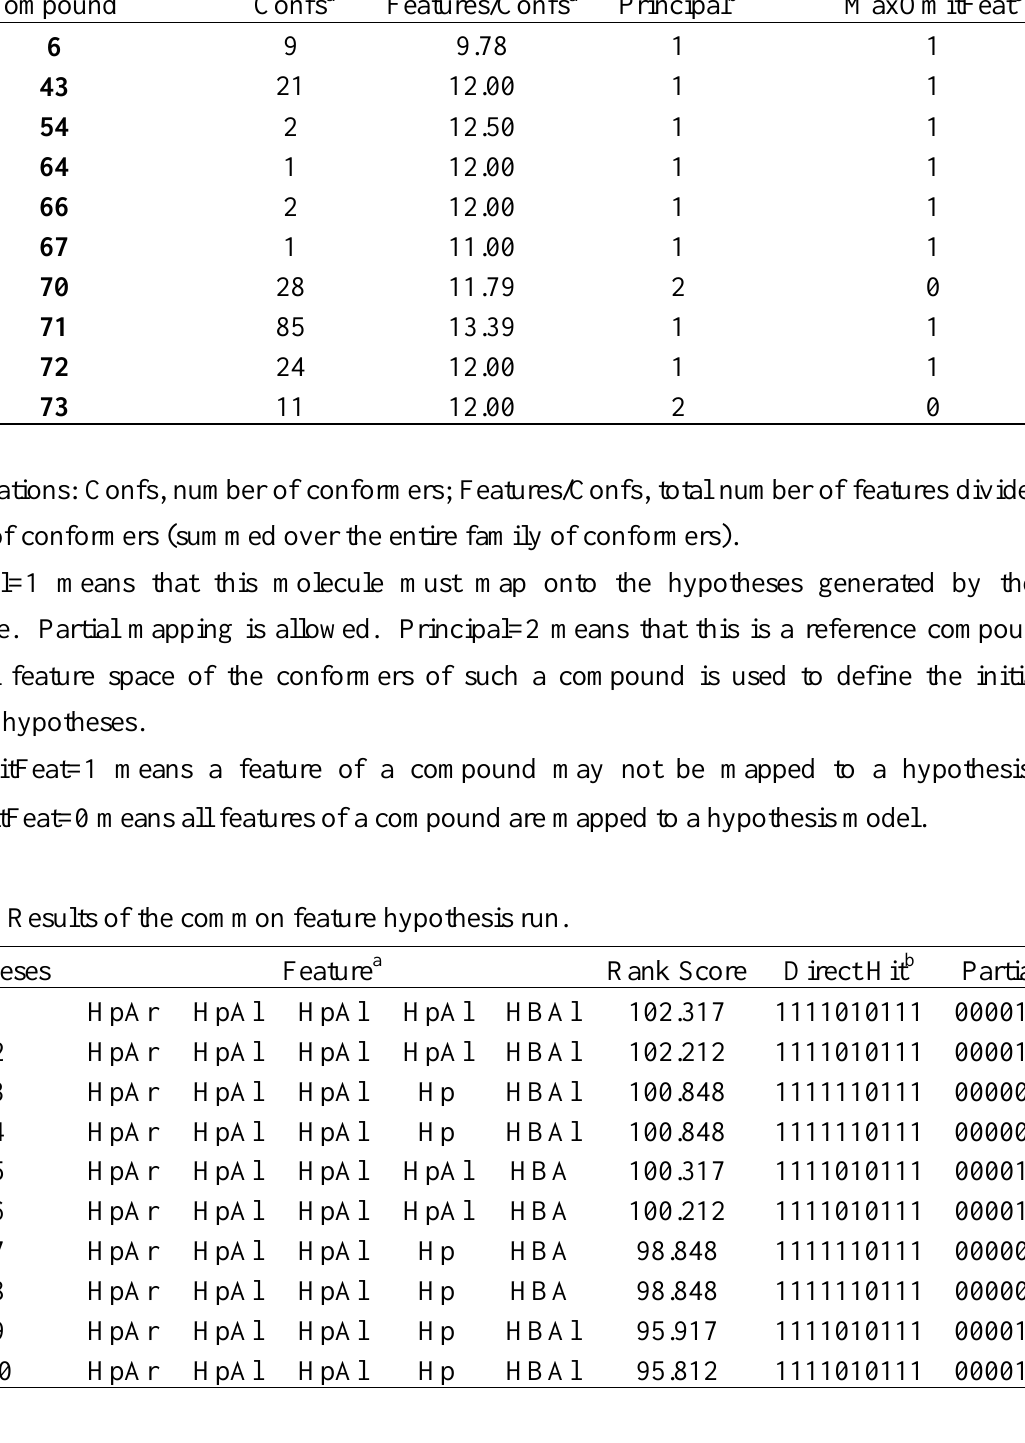
Table 3. Characteristics for the common feature hypothesis run.